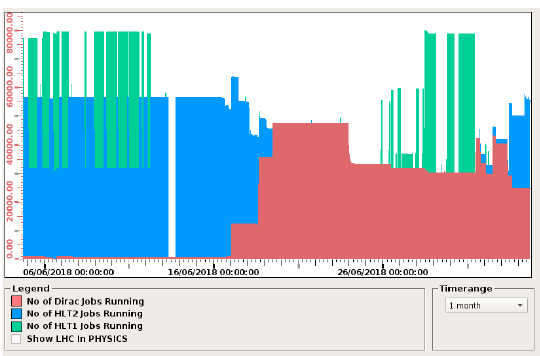
Figure 5. HLT farm activity during data taking start-up period.